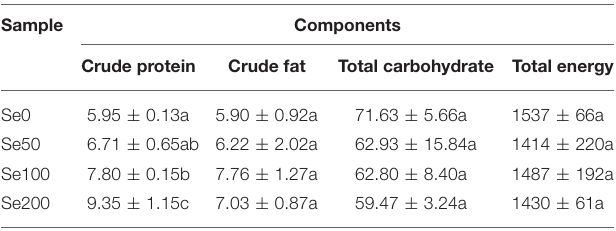
TABLE 3 | Macronutrients (g/100g DW) and total energy (kJ/100g DW) in different samples. Sample